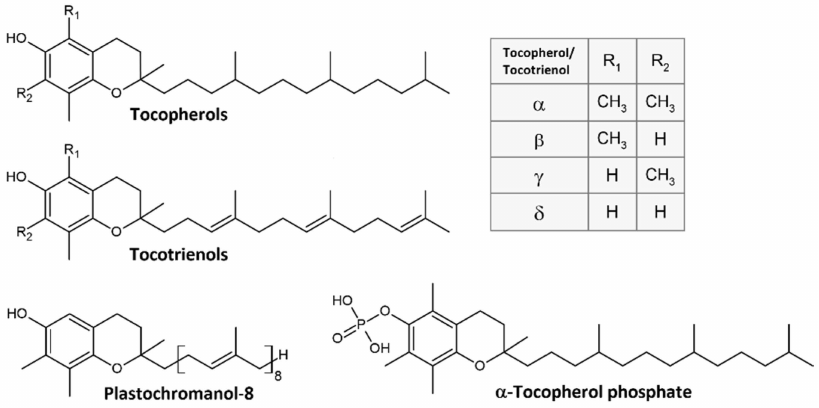
Figure 1. Chemical structure of